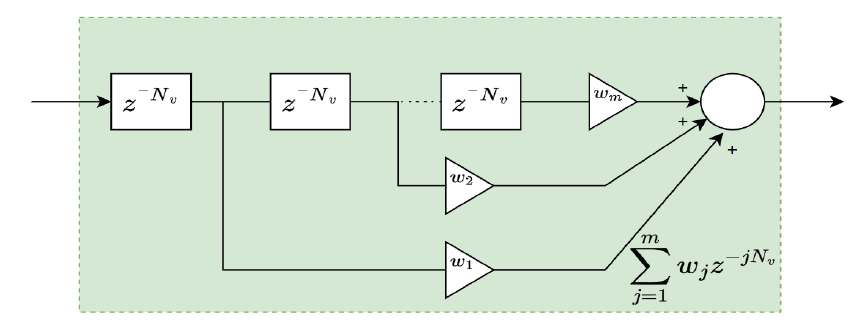
Figure 3. Realization of the proposed DIMRC.